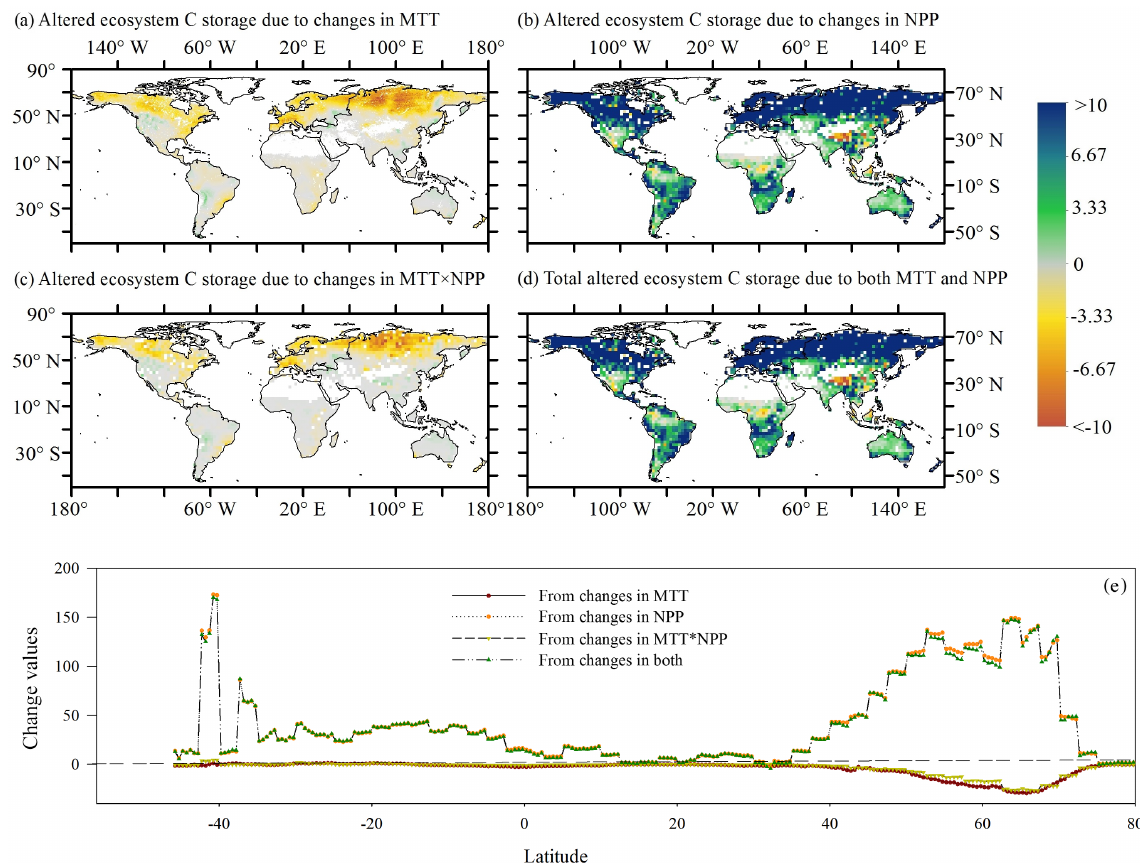
Figure 7. Altered ecosystem carbon storage due to changes in mean turnover time (MTT, NPP2011 × (cid:49) MTT, a ), net primary production (NPP, MTT2011 × (cid:49) NPP, b ) and interaction of NPP and MTT ( (cid:49) MTT × (cid:49) NPP, c ). Panels (d) and (e) are total altered ecosystem C storage changes due to changes in MTT, NPP and MTT × NPP, and their latitudinal gradients from panels (a) – (d) , respectively. Unit: gCm − 2 yr − 1 ( (cid:49) C pool = NPP 2011 × (cid:49) MTT + MTT 2011 × (cid:49) NPP − (cid:49) NPP × (cid:49)